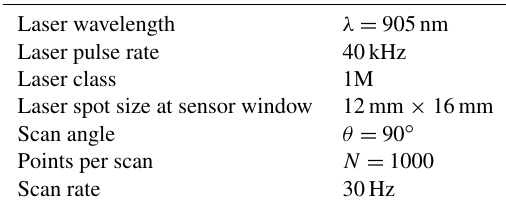
Figure 3. (a) Experimental setup for field measurements with a laser scanner on a tripod, a measurement laptop and the wind tur- bine in the background. (b) Experimental setup for field measure- ments with a camera on a tripod and the wind turbine from the side in the background used as a reference for the tower–blade tip clear- ance. Table 2. Laser scanner